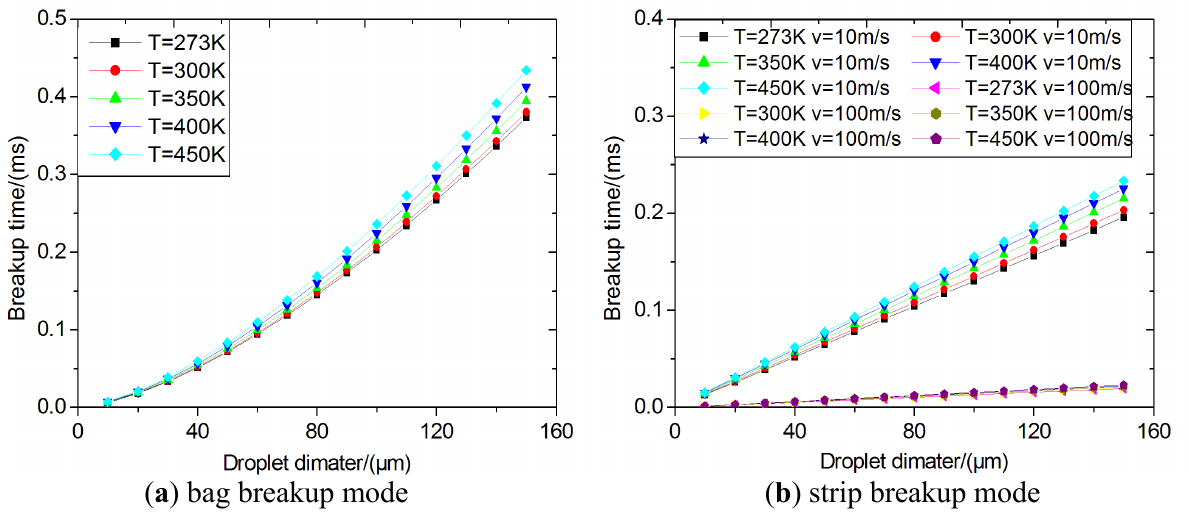
Figure 6. The lifetimes of unstable drops for two breakup mode: ( a ) bag breakup mode; ( b ) strip breakup